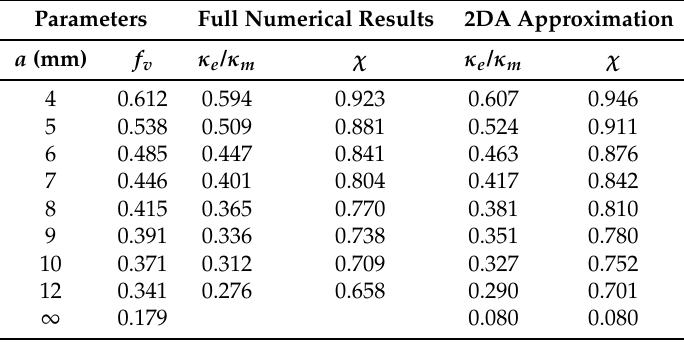
Table 2. Relative conductivity κ e / κ m and thermal conductivity efficiency χ for a closed-brick structures in air, assuming κ m = 15 κ f . The structure has a square lattice with varying parameter a . Its overall height is d = 7 mm, all the walls and the closing layer have a thickness of 1.25 mm.